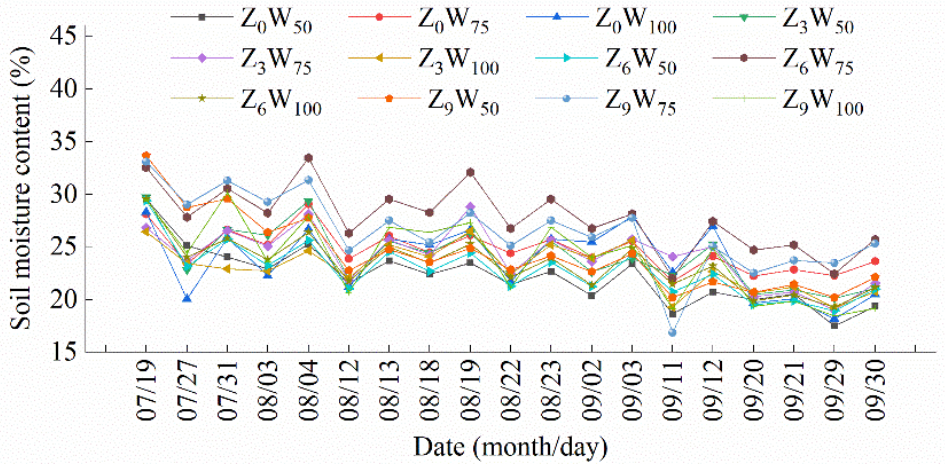
Figure 1. Effects of W - Z on variations of soil moisture during alternate drip irrigation under mulch.